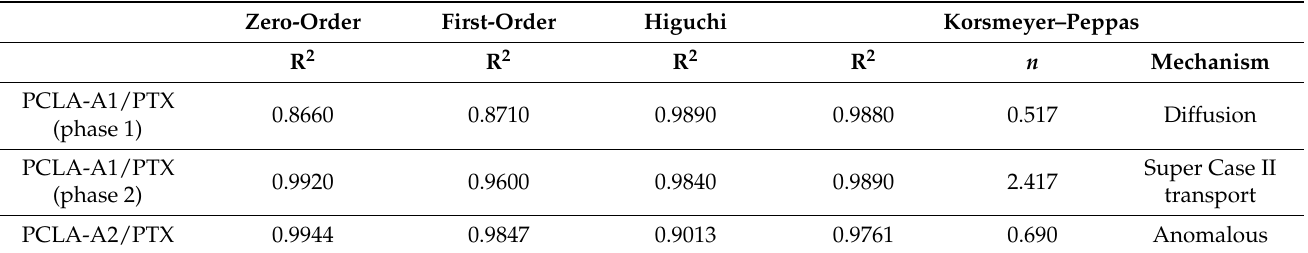
Table 8. The drug release profiles from the synthesized hydrogels, analyzed using mathemati- cal